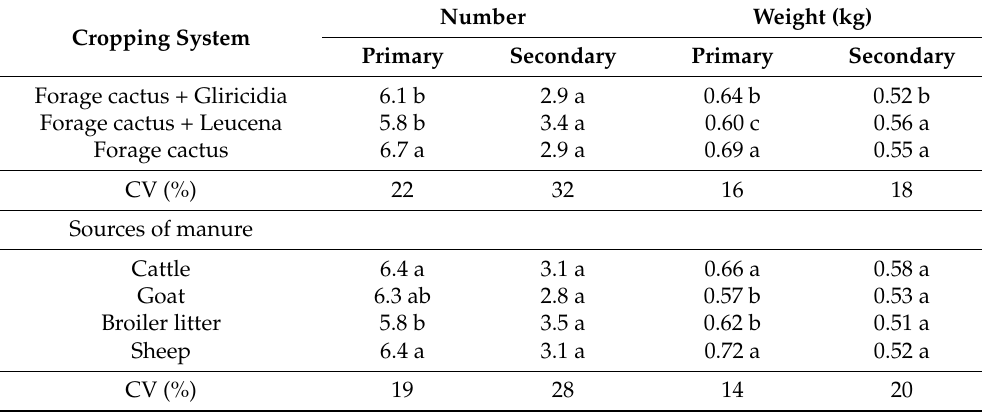
Figure 3. ForageproductionoftheforagecactusIPASert â niaatdifferentdistancesfromthearboreallegumes. Figure 3. Forage production of the forage cactus IPA Sertânia at different distances from the arboreal legumes. Table 5. The number and weight of cladode of forage cactus clone IPA Sert â nia submitted to different cropping systems and manure sources.